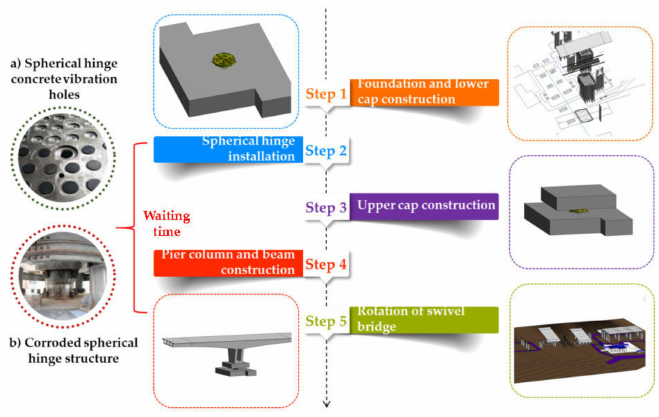
Figure 1. Construction process of the swivel